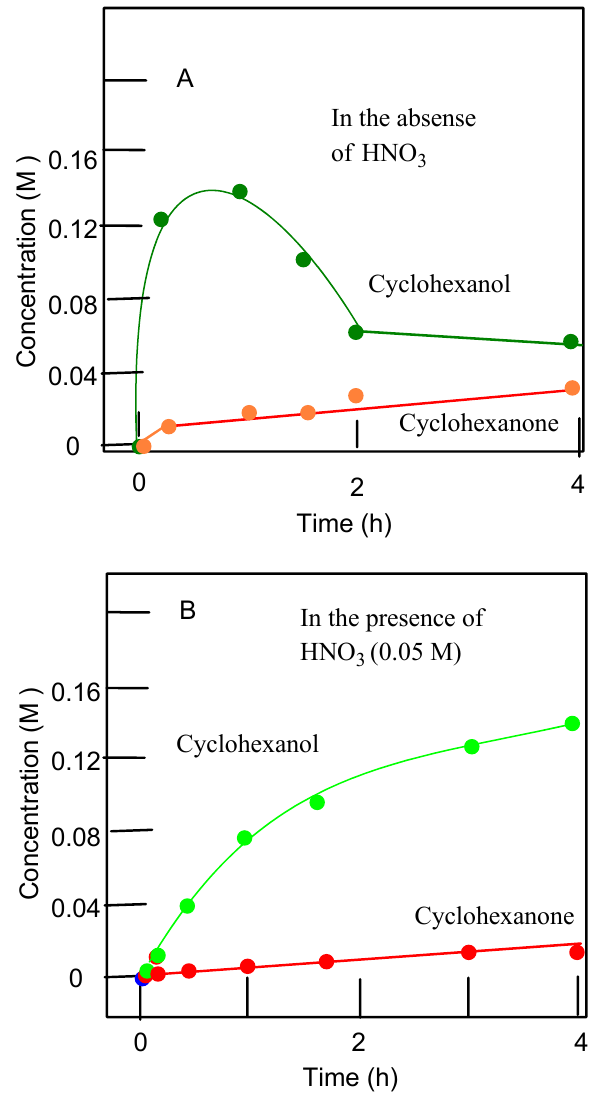
Figure 6. Accumulation of cyclohexanol and cyclohexanone in oxidation of cyclohexane (0.46 M) with hydrogen peroxide (2.0 M, 50% aqueous) catalyzed by compound 2 (5 × 10 − 4 M) in MeCN at 50 °C. Concentrations of cyclohexanone and cyclohexanol were determined after reduction of the aliquots with solid PPh 3 . Graph A: in the absence of HNO 3 . Graph B: in the presense of HNO 3.